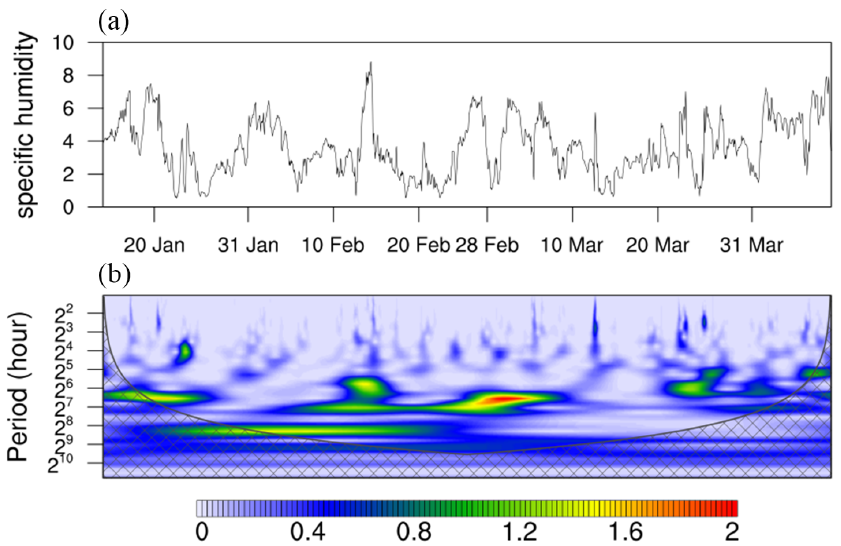
Figure 4. ( a ) Time series of the 850-hPa specific humidity ( 𝑞 , in g/kg) in Venado (38.5° N, 123° W), California. ( b ) The wavelet power spectrum of ( a ). The left axis is the period (in hour), and the bottom axis is time.